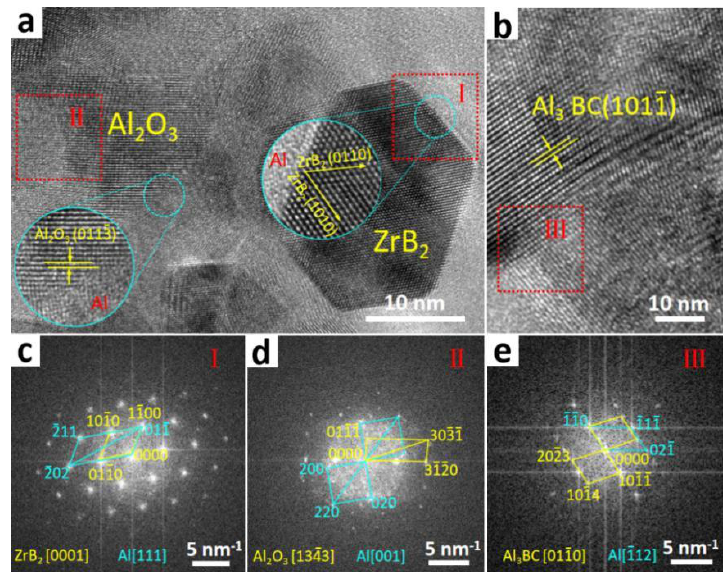
Figure 4. ( a , b ) The HRTEM images of the (ZrB 2 + Al 3 BC + Al 2 O 3 )/Al composite; ( c – e ) The Figure4. ( a , b )TheHRTEMimagesofthe(ZrB 2 + Al 3 BC + Al 2 O 3 ) / Alcomposite; ( c – e )Thecorresponding corresponding FFT patterns of the nanoparticles in ( a , b ). FFT patterns of the nanoparticles in ( a , b ). Materials 2020 , 13 , x FOR PEER REVIEW 6 of 10